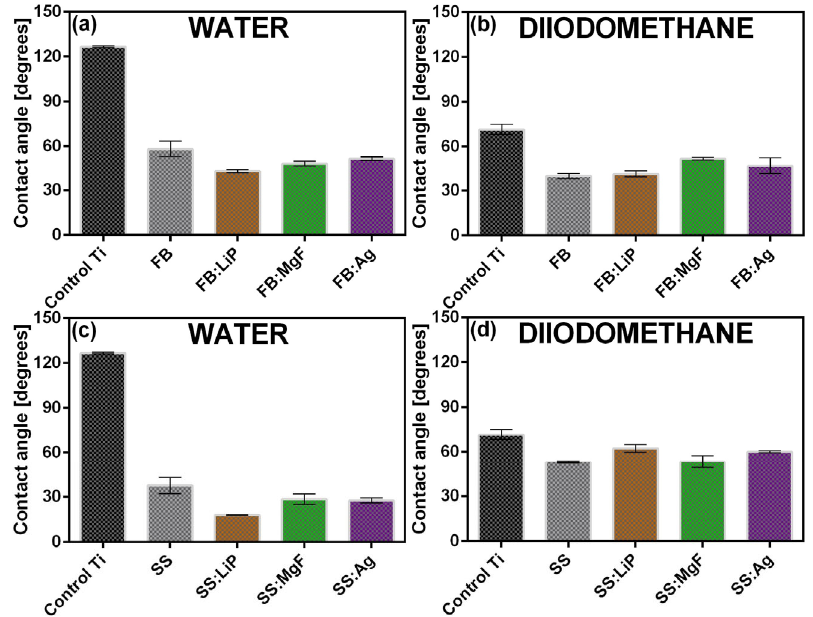
Figure 5. The contact angle values inferred in the case of Ti and simple and doped FB ( a , b ) and